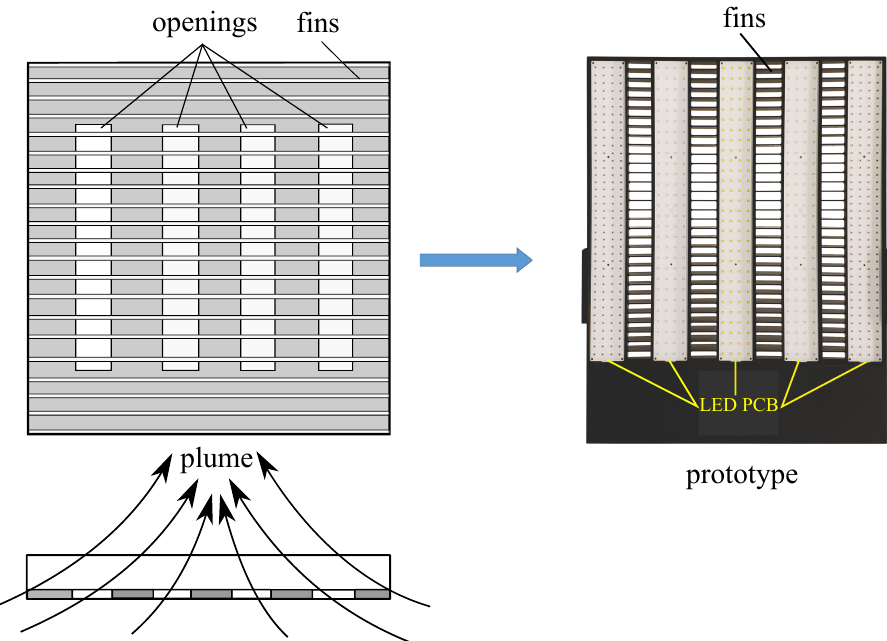
Figure 1. Schematic of the proposed rectangular array of straight fins with transverse openings in the base for natural convection cooling of LED grow lights ( left ) and a prototype LED grow light with the proposed heat sink ( right ). The black area in the right-hand figure represents the LED power electronics. The openings increase the vertical flow of air around the fins. Typically, the array is square with sides of about 500